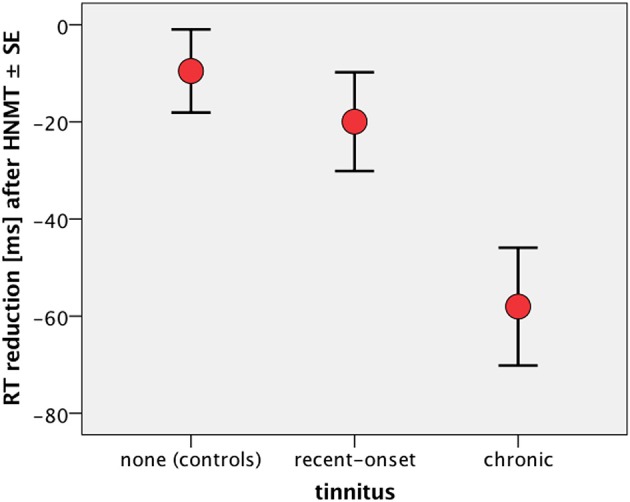
RT difference (after – before) over the 1-week study period in the GO condition. “Treated” healthy participants served as active controls (n = 22) to compare the mental acceleration due to the compact HNMT in treated patients with recent-onset (n = 21) and chronic tinnitus (n = 21). RT was significantly reduced in chronic patients compared to both recent-onset patients (Mann–Whitney-U tests; p < 0.05) and active controls (p < 0.005). There was no significant RT difference between active controls and recent-onset patients (p > 0.63).